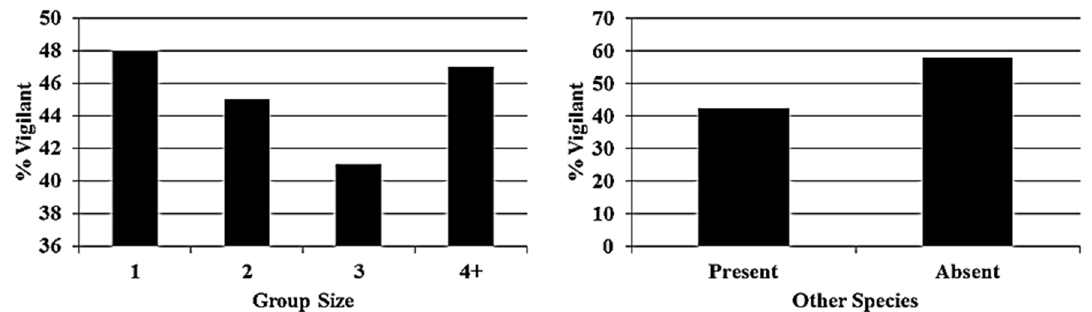
than raccoons to be active during daylight hours (Figure 4).